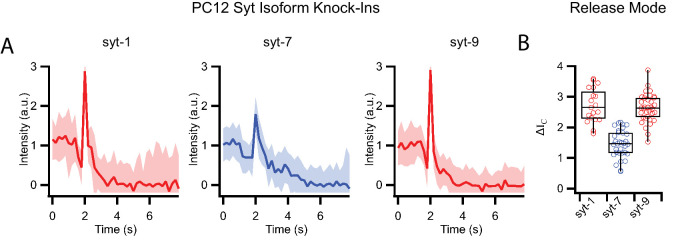
Release modes of PC12 dense core granules expressing only single synaptotagmin isoforms in a single vesicle/supported membrane fusion assay.(A) Averaged fluorescent line shapes of dense core vesicle release events (20 traces per average) for each synaptotagmin isoform with syt1 and syt9 having fast release rates and syt7 having slow release rates. (B) Release modes of single events measured by the peak intensities ΔIC during fusion of dense core vesicles with supported membranes for different synaptotagmin isoforms.